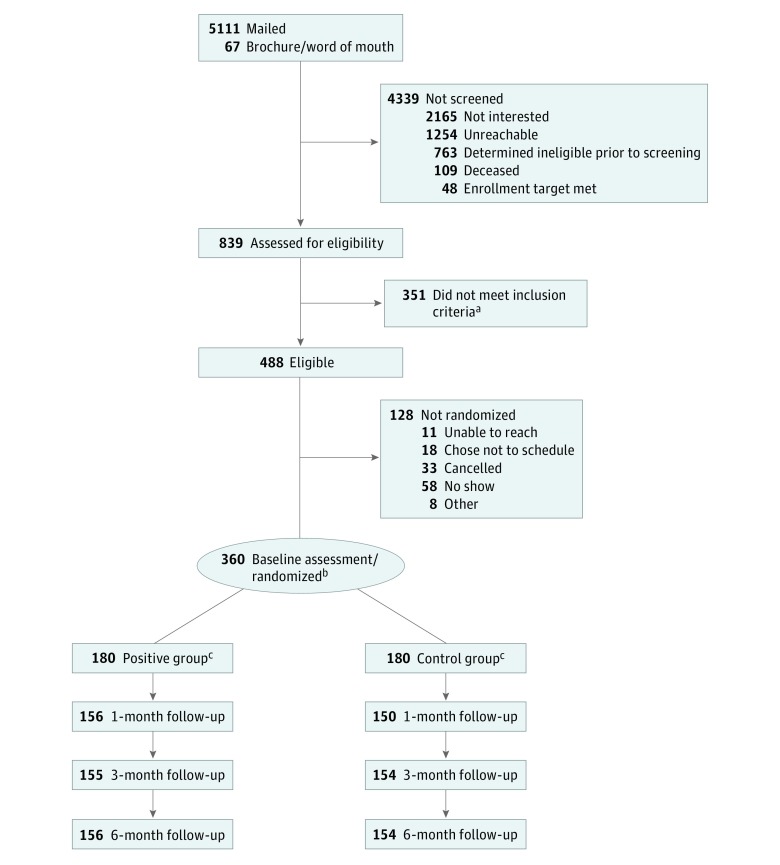
CONSORT Flow Diagram for the Staying Positive With Arthritis StudyaReasons for ineligibility are provided in eTable 1 in Supplement 2.bRandomization was at the patient level, stratified by site and self-reported race.cDetails on reasons for missing data points are provided in eTable 2 and eTable 3 in Supplement 2.